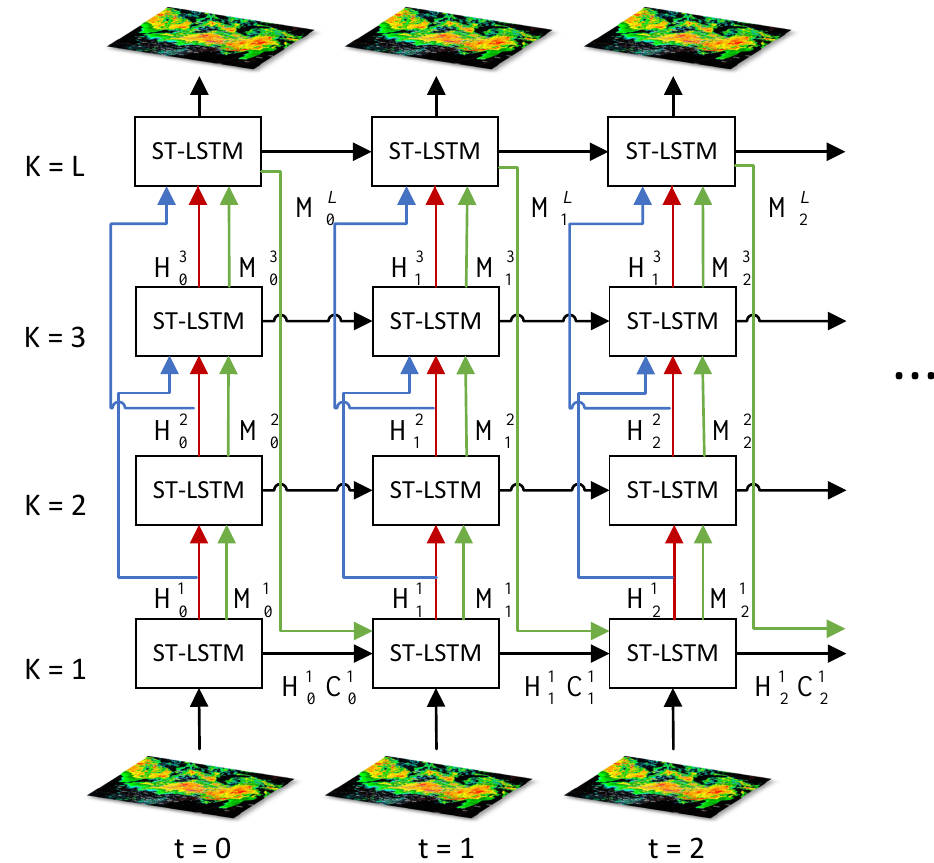
Figure 1. The structure of the rc-LSTM model. The green arrow shows the transition paths of state M, the red arrow shows the transition paths of the hidden state H. The subscript represents the time and the superscript represents the layer. rcLSTM adopts a series structure, and the output of the bottom layer is used as the input of the high layer. In particular, the output of the highest layer represents the predicted value of the next moment. For the first layer, in the feature extraction stage, the input of each moment is the real observation value of the radar echo, and in the prediction stage, the predicted radar echo of the previous moment is used as the input of the next